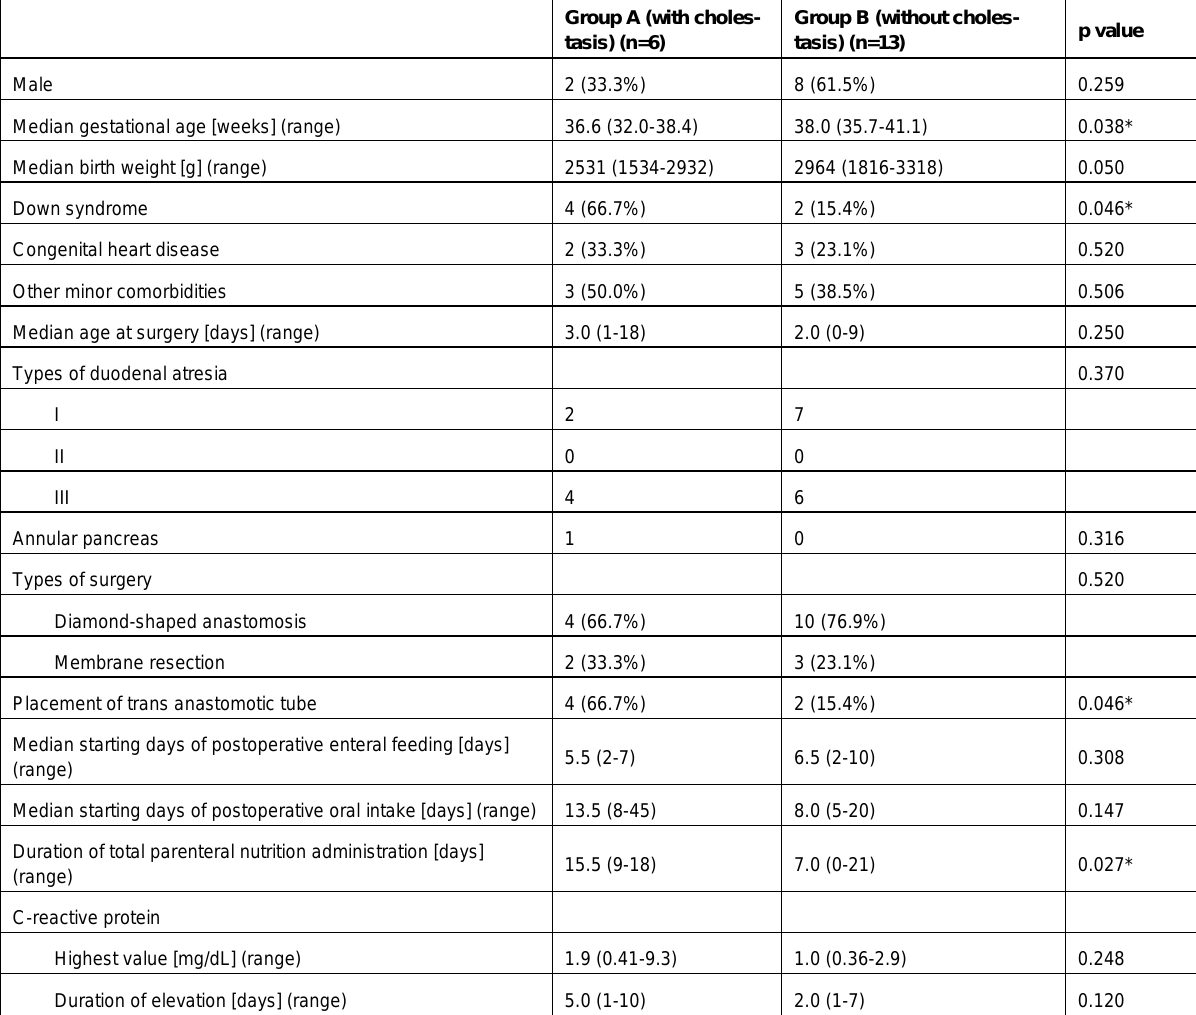
Table 1. Univariate analyses to determine risk factors for postoperative jaundice in neonates with duodenal